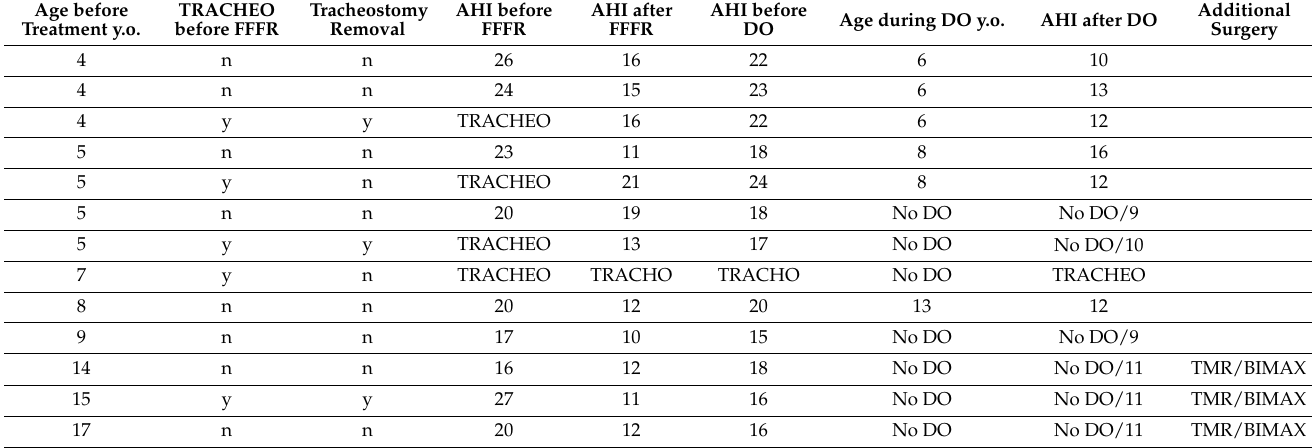
Table 3. Analysis of OSA based on AHI in patients undergoing FFFR, after fibular flap reconstruc- tion. FFFR—free fibula flap reconstruction, TMR—temporo mandibular reconstruction alloplastic prosthesis, BIMAX—orthognathic bimaxillary surgery, TRACHEO—tracheostomy, DO—distraction osteogenesis, n—no tracheostomy, y—yes tracheostomy. Age before Treatment